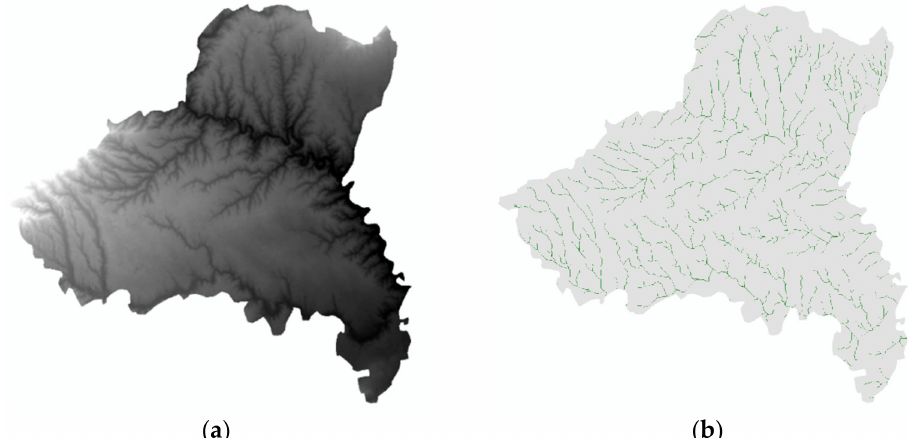
Figure 9. ( a ) 30-m resolution DEM data in Baishui County; ( b ) river network extraction results in Baishui